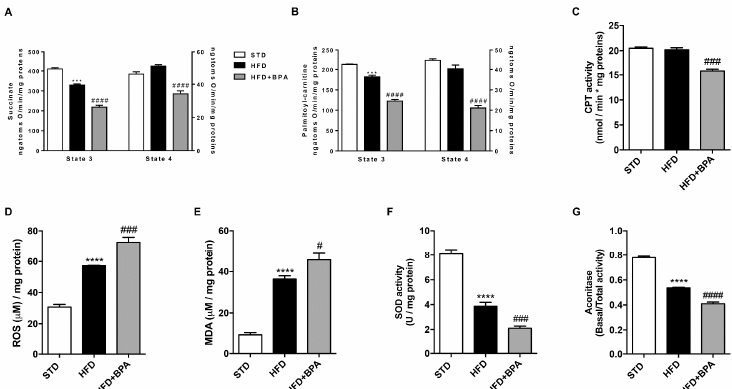
Figure 3. BPA e ff ect on liver mitochondrial dysfunction and oxidative stress induced by HFD. ( A ) Mitochondrial state 3 and 4 respiration and ( B ) oxygen consumption linked to fatty acid oxidation were measured in the liver from all experimental groups using succinate or palmitoyl-carnitine as substrates, respectively. ( C ) The mitochondrial carnitine palmitoyl-transferase (CPT) activity in the liver of BPA-treated mice was determined. BPA worsening e ff ect on HFD-induced ( D ) hepatic reactive oxygen species (ROS), and ( E ) malondialdehyde (MDA) levels was shown. Hepatic mitochondrial ( F ) superoxide dismutase (SOD) and ( G ) aconitase activity was spectrophotometrically measured. Data are presented as means ± SEM of all animals ( n = 6 each group) (*** p < 0.001, and **** p < 0.0001 vs. STD; # p < 0.05, ### p < 0.001, and #### p < 0.0001 vs. HFD).